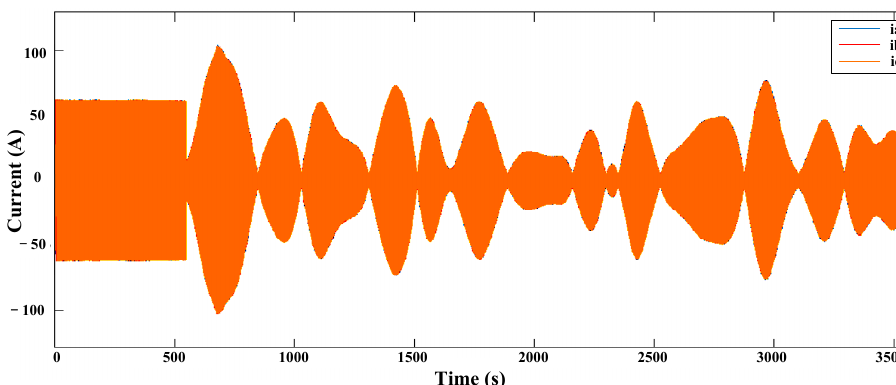
Figure 12. The three-phase current waveform.